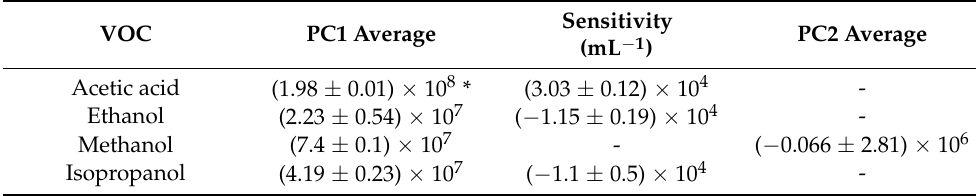
Table 2. Summarization of the values achieved from Figure 3b,c. The columns PC1 Average and PC2 Average represent the mean value calculated from data of Figure 3b,c for the case of methanol, not considering the null concentration data. The sensitivity corresponds to the slope of the straight lines fitting PC2 data displayed in Figure 3c.